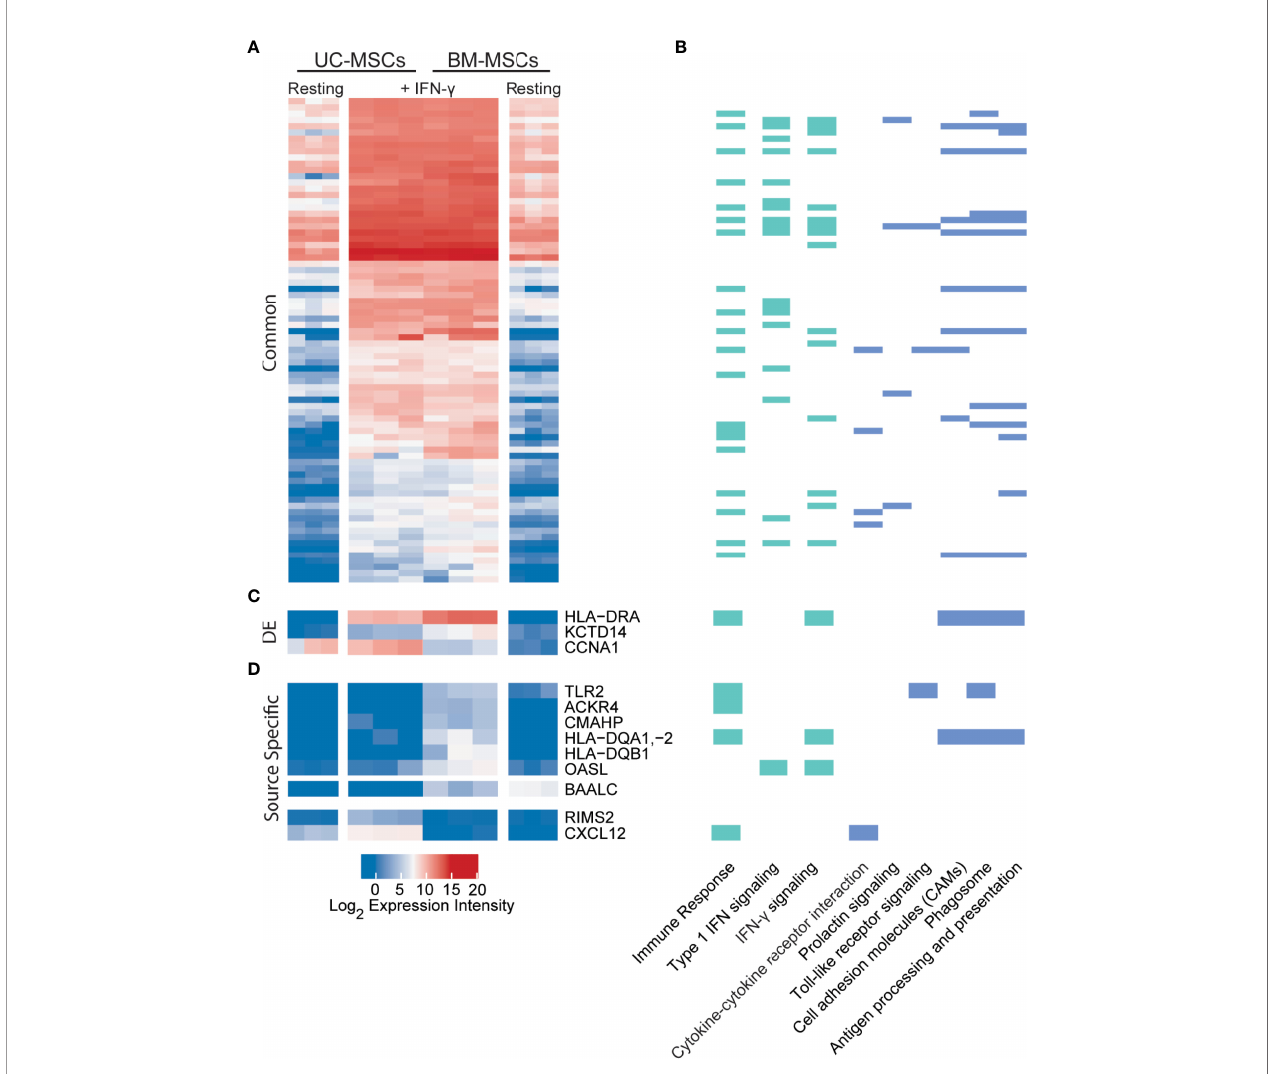
FIGURE 4 | UC and BM-MSCs exhibit robust and highly similar transcriptome responses to to IFN- g . (A) Seventy-eight DE genes were signi fi cantly upregulated in both MSC types by IFN- g activation. (B) IFN- g activation results in functional enrichment of immune and IFN signaling GO processes (green), among others (see complete list in Table S4 ), and 6 KEGG pathways (blue). (C) Three genes were upregulated by both UC and BM-MSCs but to signi fi cantly different levels. (D) Nine genes were expressed in a source-speci fi c manner. 6 were upregulated speci fi cally in BM-MSCs, while 2 were solely increased in UC-MSCs. One gene, BAALC , was downregulated in BM-MSCs but remained undetected in UC-MSCs. BM, bone marrow; DE, differentially expressed; IFN, interferon; MSC, mesenchymal stromal cell; UC, umbilical